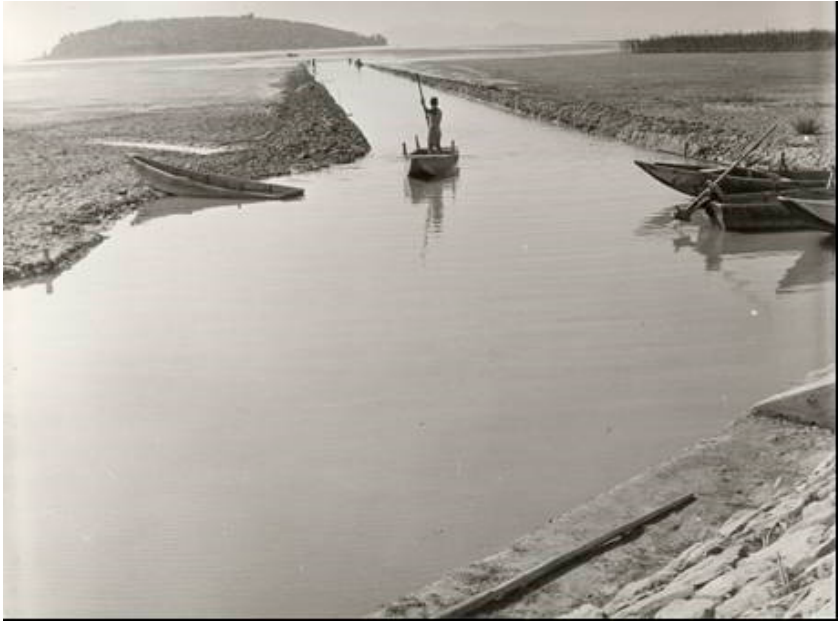
Figure 1. The water crises in 1958 (photographic archive of the “Provincia di Perugia”).